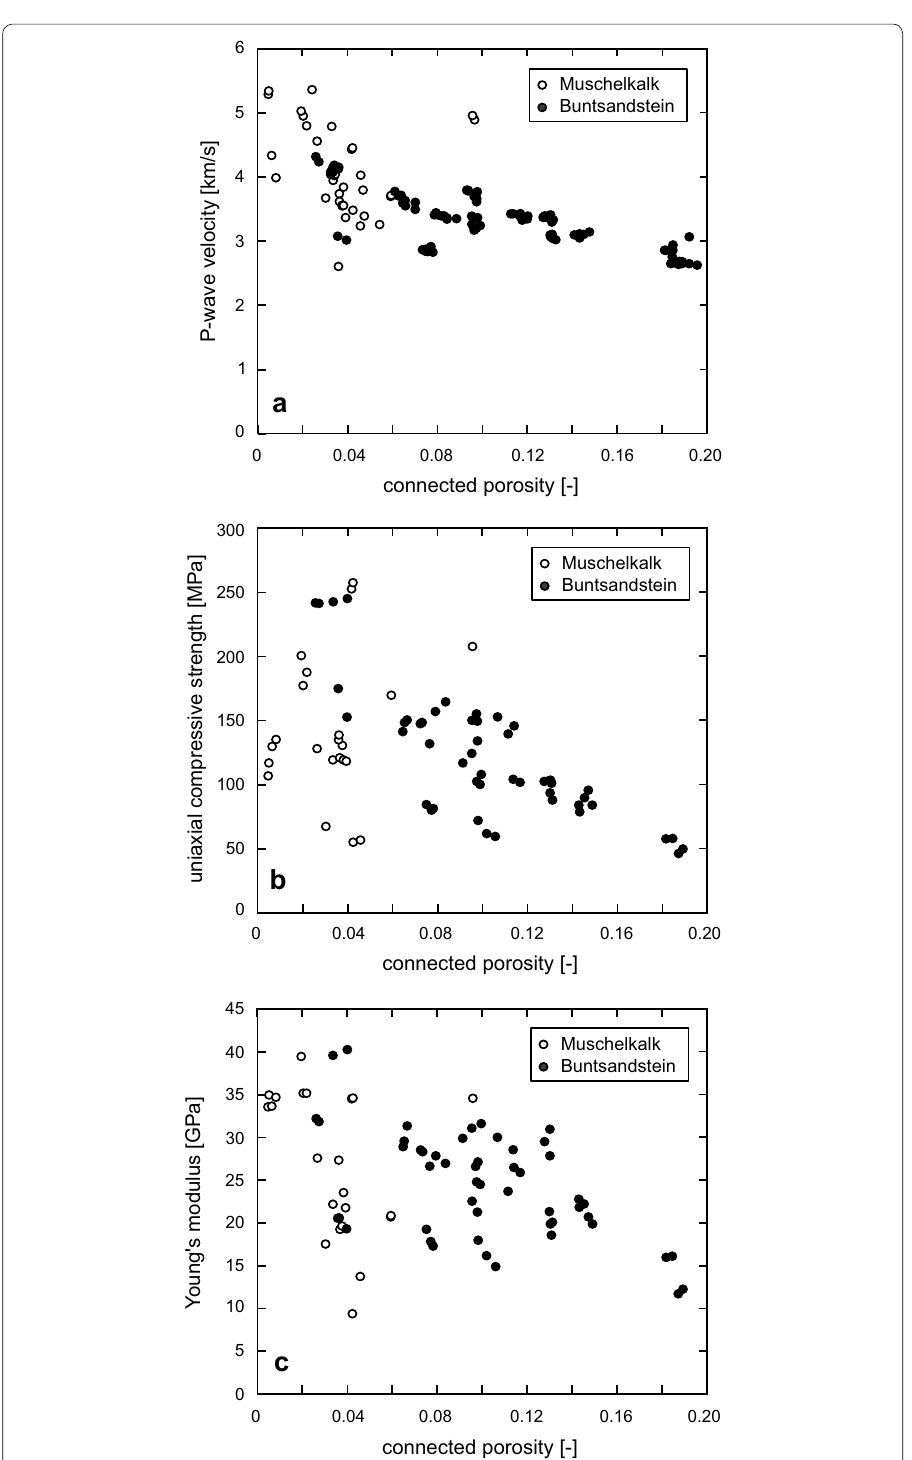
Fig. 10 a Dry P-wave velocity, b dry uniaxial compressive strength, and c dry Young’s modulus as a function of connected porosity for Muschelkalk (white circles) and Buntsandstein (black circles) samples from exploration well EPS-1 (Soultz-sous-Forêts). Data for the Buntsandstein from this study and Heap et al. (2017, 2018,